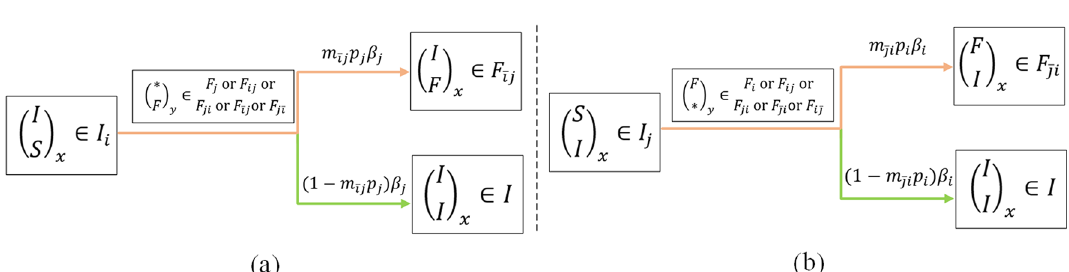
Figure 5. Cross-transmission process of two related information in an active forwarding period: ( a ) forward information i then forward information j successively; ( b ) forward information j then forward information i successively.